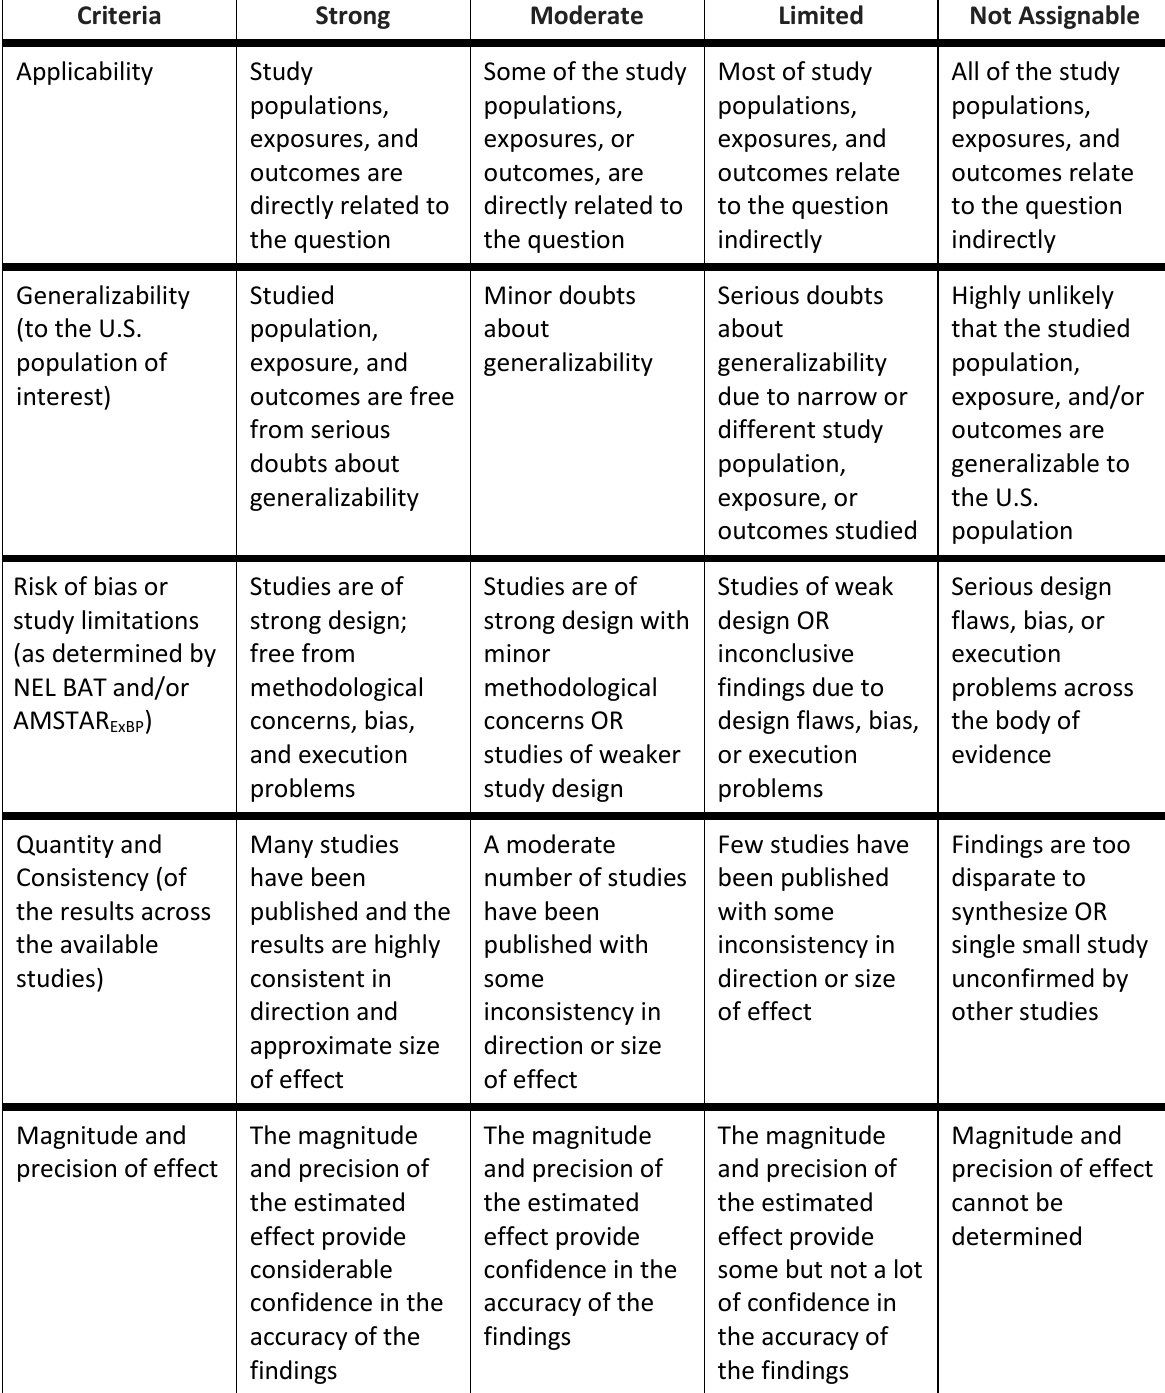
Table E-1. 2018 Physical Activity Guidelines Advisory Committee Grading